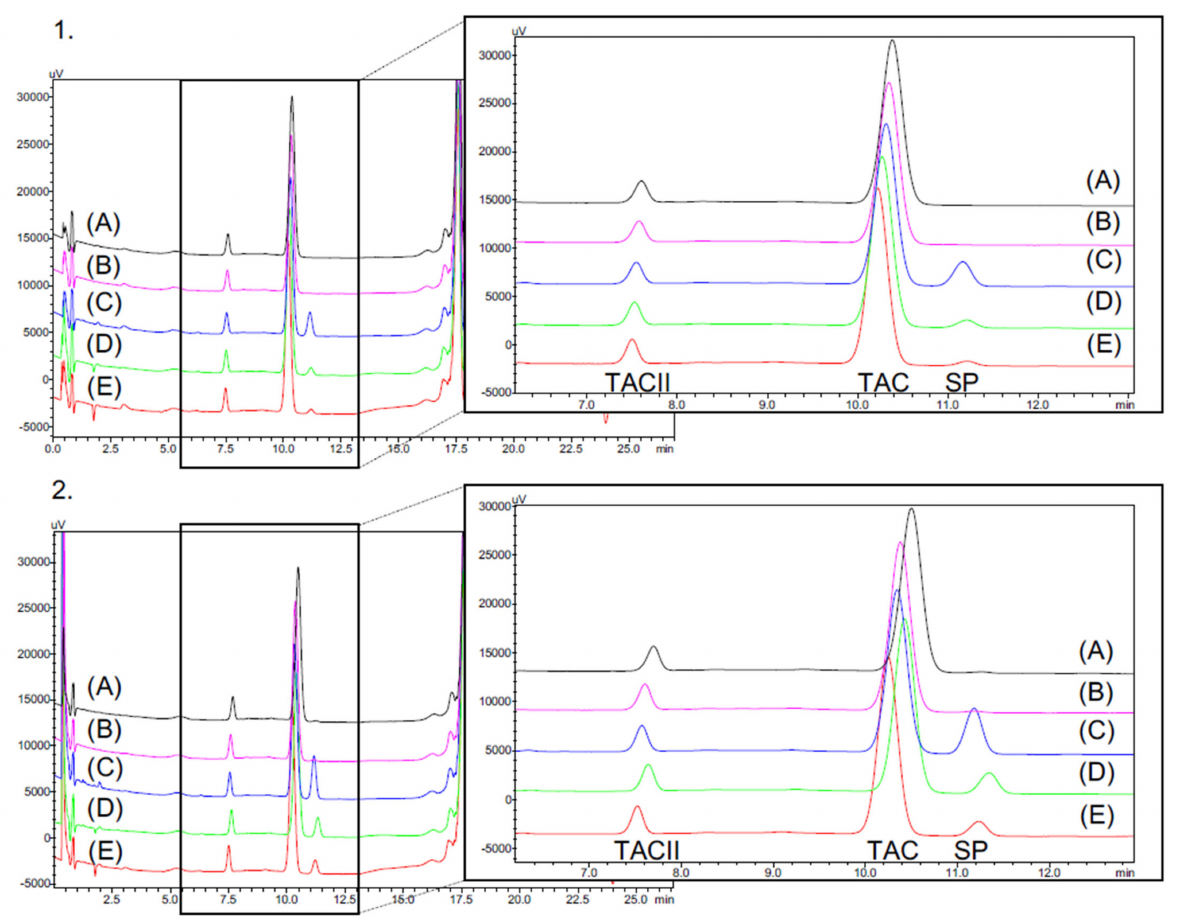
Figure 7. In use assay on the 1 mg/mL ( 1 ) and 0.2 mg/mL ( 2 ) formulations with (A): formulation stored eight months at 5 ◦ C, (B): Day 0 = first drop, (C): Day 0 = second drop, (D): Day 14= 28th drop and (E): 56th drop after 28 days of analysis. SP = Supplementary peak.